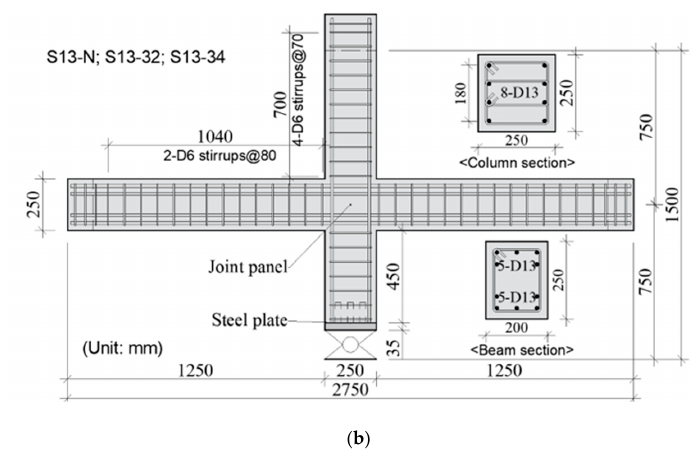
Figure 1. Dimensions and reinforcement details of the specimens. ( a ) Group 1 and Group 3 specimens, ( b ) Group 2 specimens.